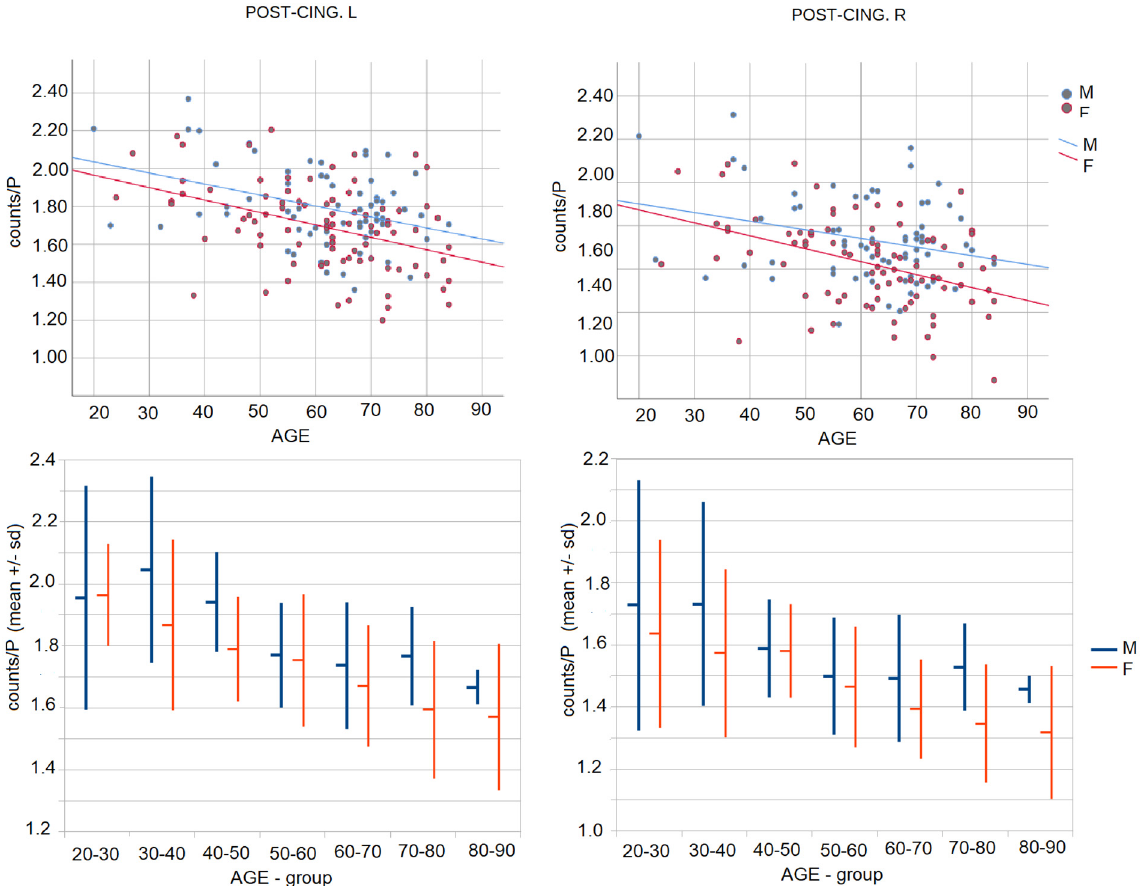
Figure 4. Posterior cingulate (POST-CING) activity in female vs. male, with lower media of 18F-FDG uptake in year decades after 50. M = male, F = female, L = left; R = right. Table 2. Significant ( p < 0.001) negative correlation between age and 18F-FDG uptake resulting by SPSS (Statistical Package for Social Science) analyses, using pons 18F-FDG activity as normalization reference in anatomical regions for male ( a ) and female ( b ) separately. ROI = region of interest; r = Pearson coefficient; L = left; R = right. ( a